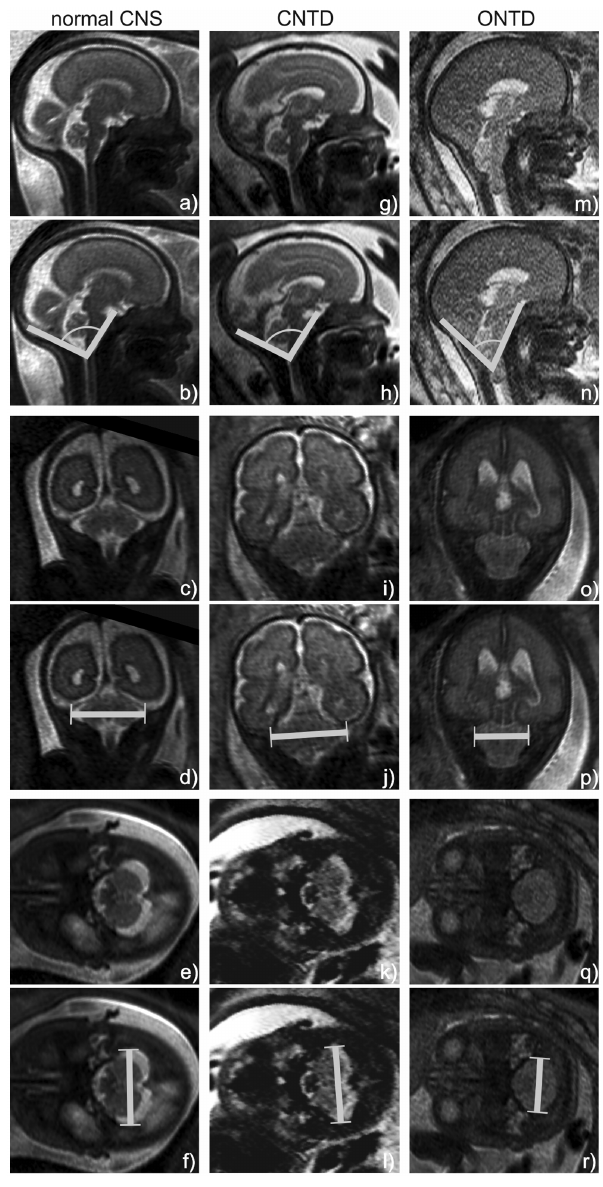
Figure 2. Line drawings show measurements of the CSA and TDPF performed on MR images of three exemplar fetuses: one fetus with normal CNS development at 27 GW (a–f), one fetus with a CNTD at 28GW (g–l) and one fetus with an ONTD at 27 GW (m–r). The CSA was measured on midsagittal T2-weighted SSFSE MR images (a + b, g + h, m + n). The TDPF was measured on coronal T2- weighted MR images (c + d, i + j, o + p) or on axial T2-weighted MR images (e + f, k + l, q +